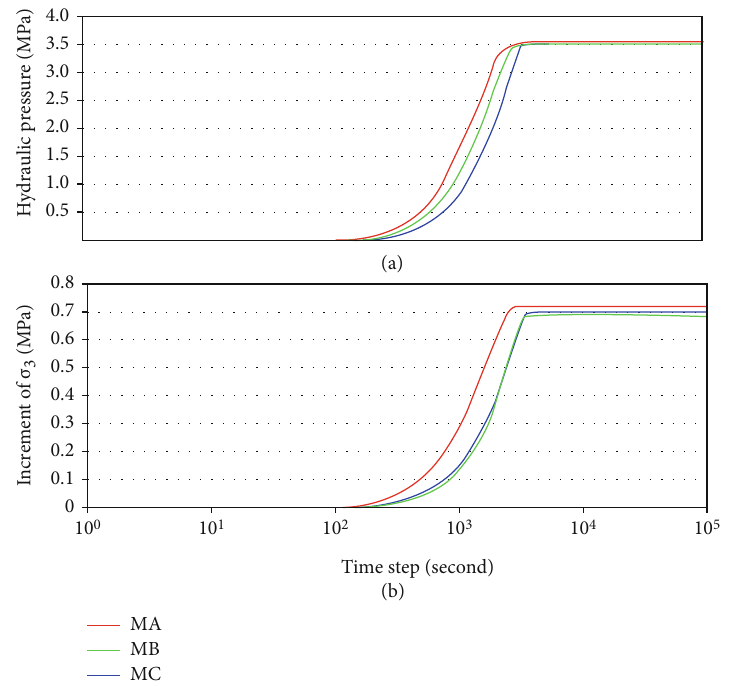
Figure 11: Evolutions of the hydraulic pressures and incremental tensile